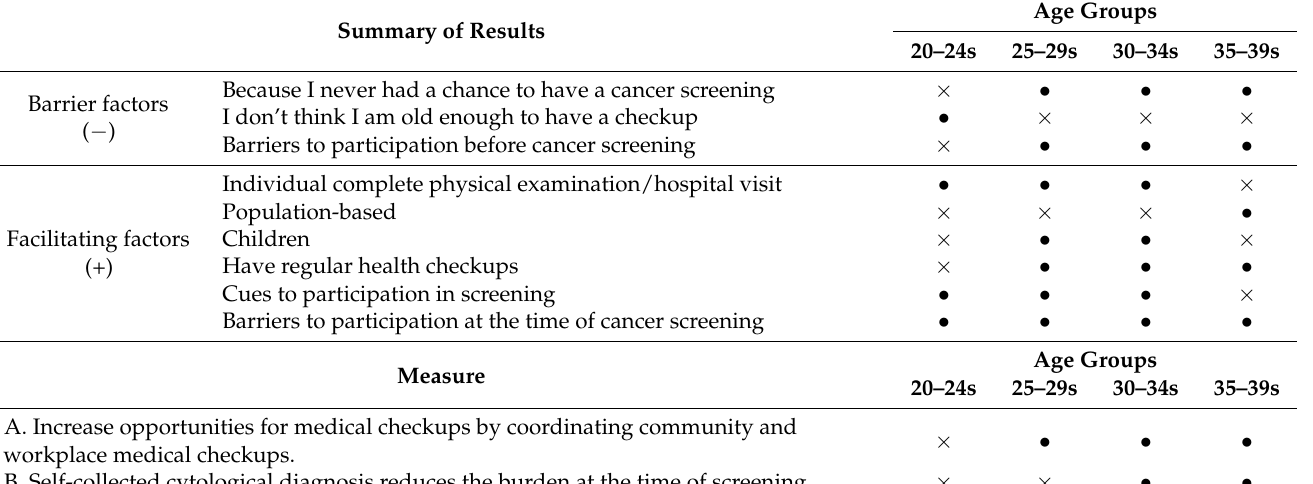
Table 5. Summary of results and points to consider when recommending medical